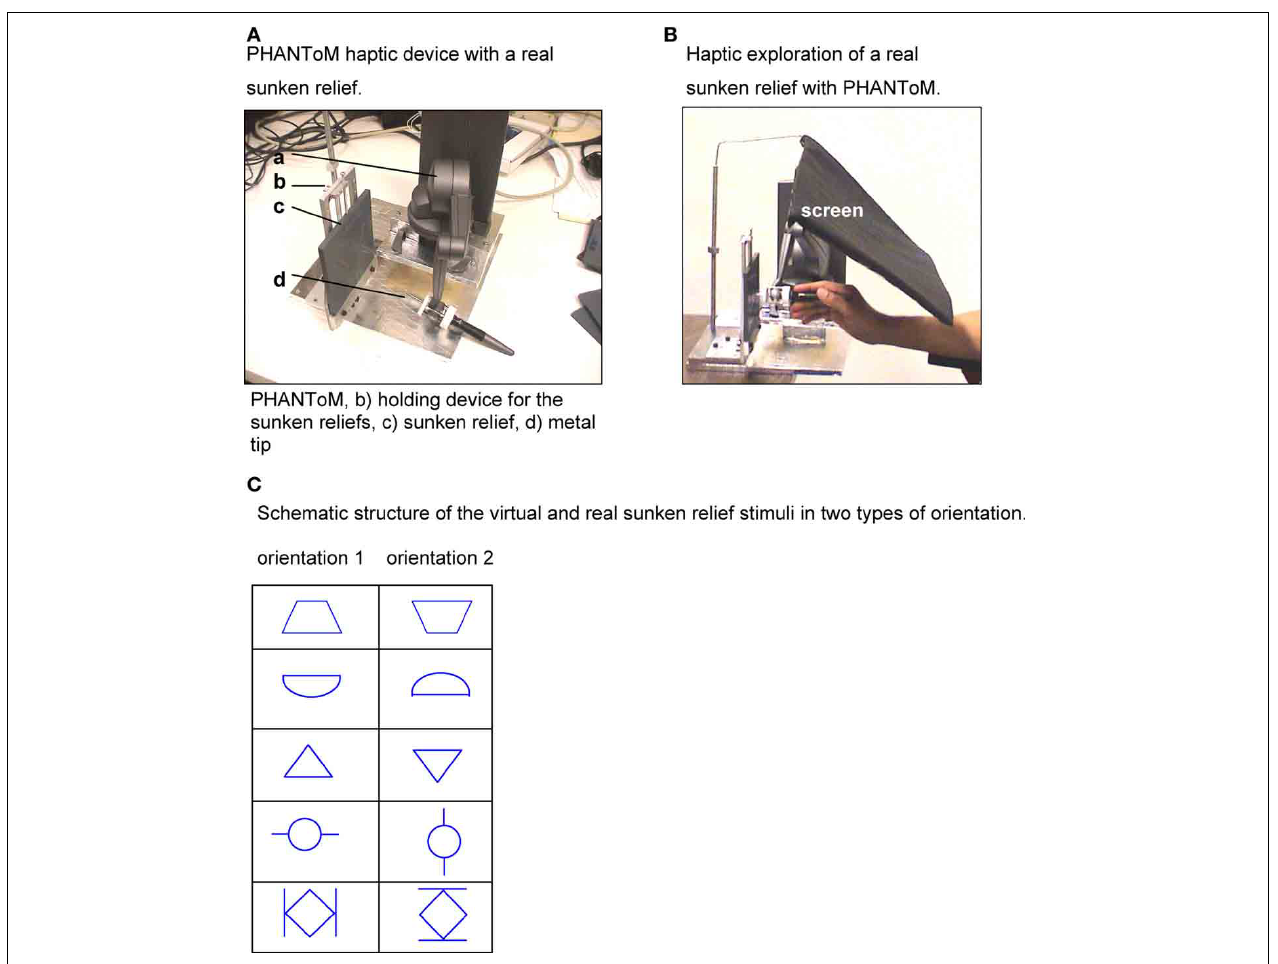
FIGURE 2 | (A) PHANToM haptic device with a real sunken relief. (B) Haptic exploration of a real sunken relief with PHANToM. (C) Schematic structure of the virtual and real sunken relief stimuli in two types of orientation.